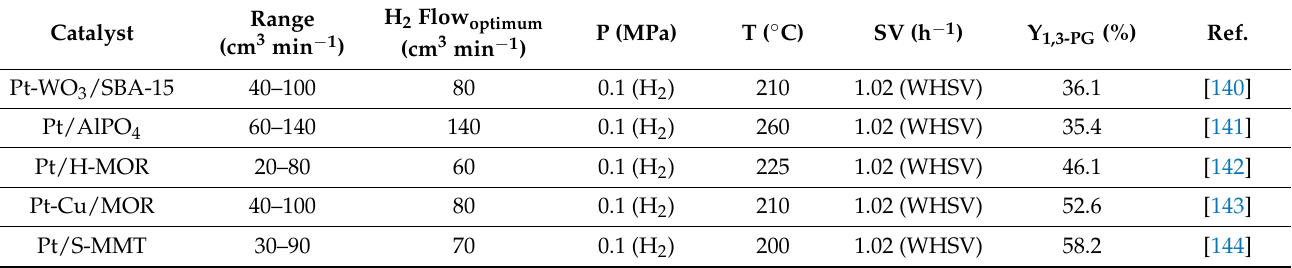
Table 13. The effect of H 2 flow in continuous flow